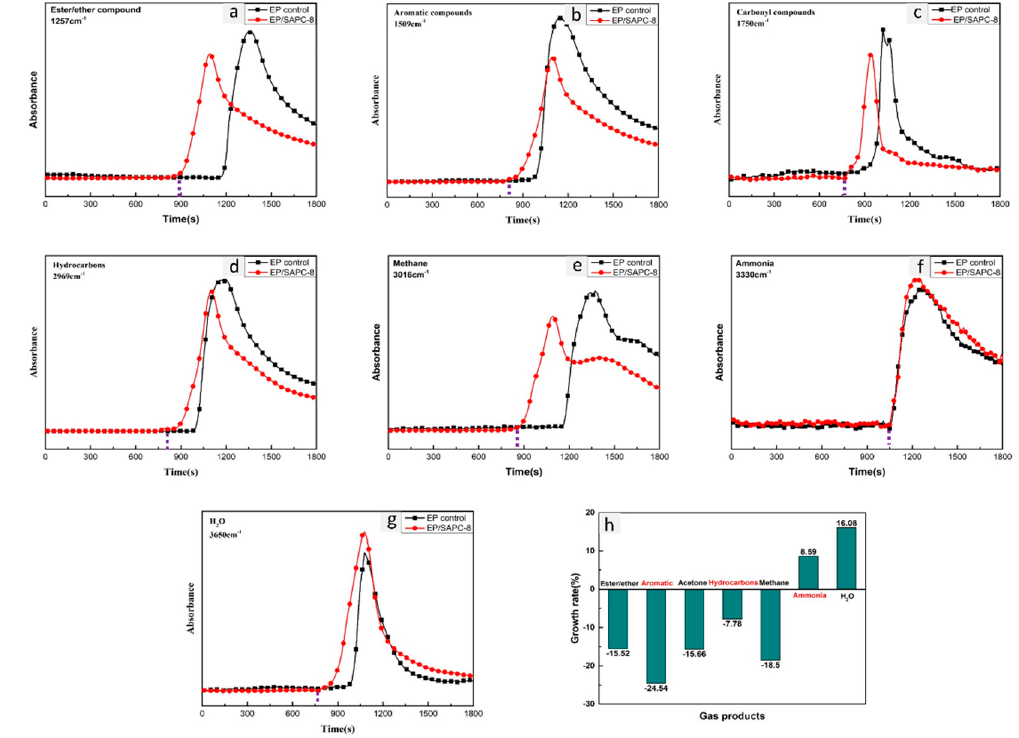
Figure 12. Absorbance of pyrolysis products for EP control and EP / SAPC-8 vs. time: ( a ) esters / ethers, ( b ) aromatic compounds, ( c ) carbonyl compounds, ( d ) hydrocarbons, ( e ) methane, ( f ) ammonia, ( g ) H 2 O, ( h ) various gas pyrolysis product growth rates. Table 1. Infrared characteristic peak of the main pyrolysis product groups.